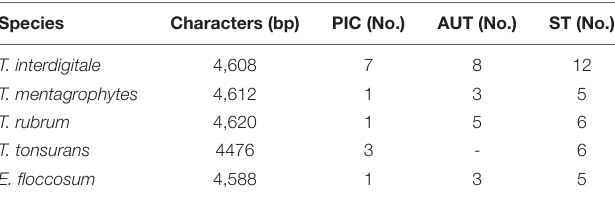
TABLE 3 | The data obtained from the maximum parsimony analysis and phylogenetic analysis of seven loci. Species